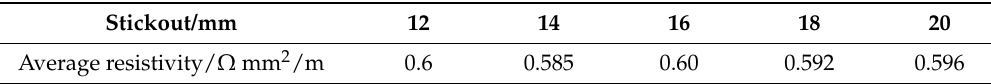
Figure 10. Temperature distribution along the wire. Table 1. The average resistivity for different